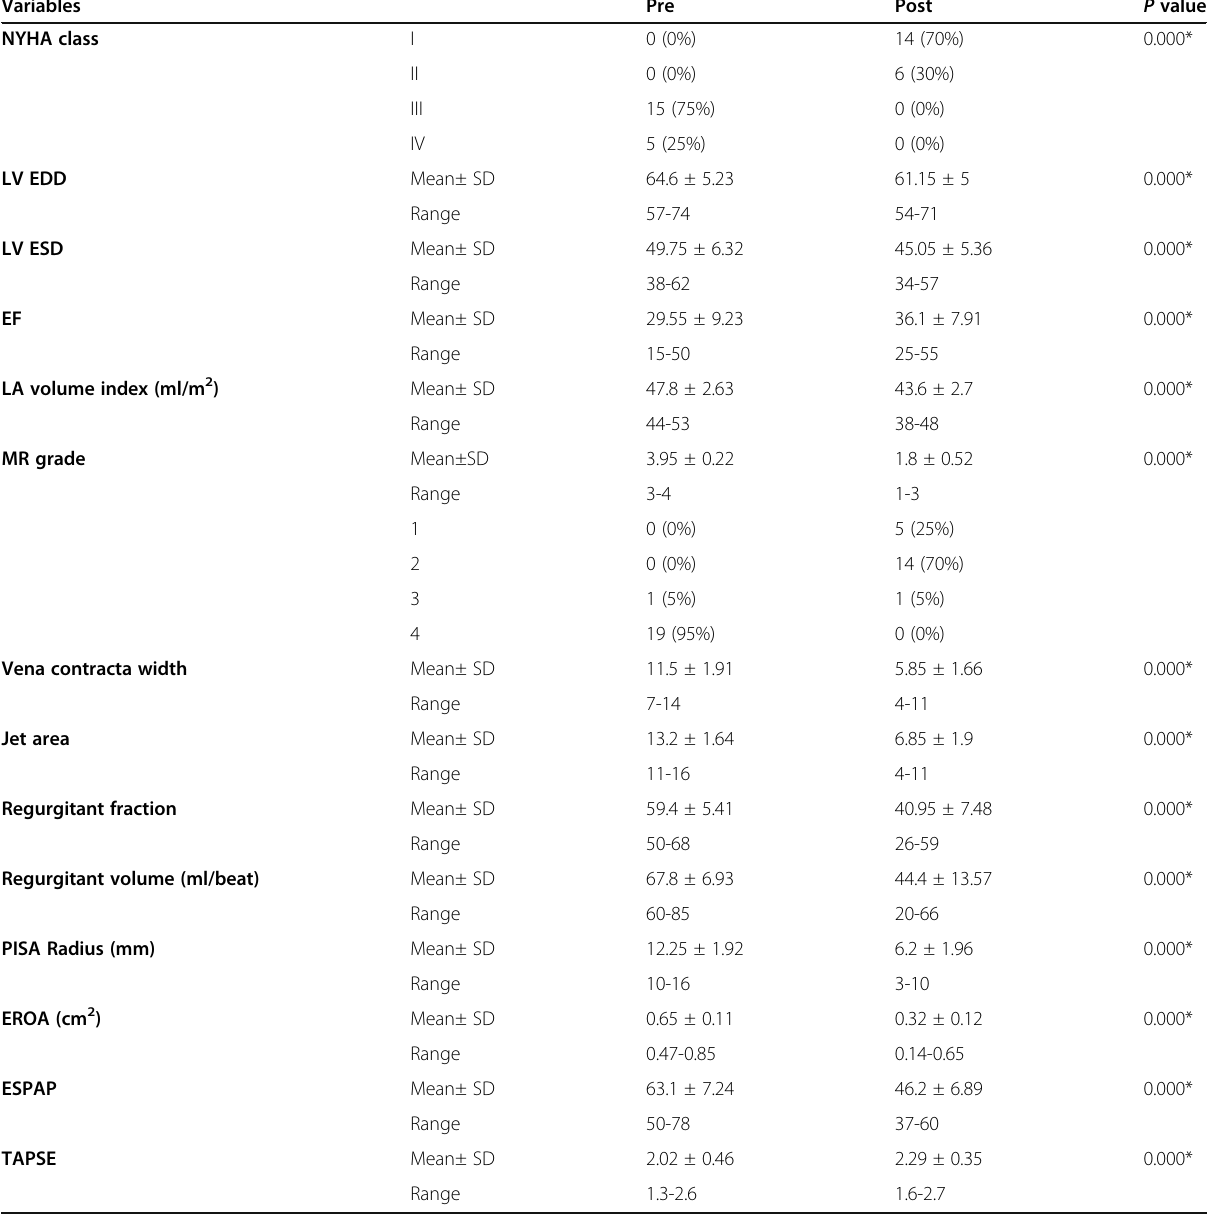
Table 2 Paired comparisons between pre- and post-mitral clipping measurements Variables